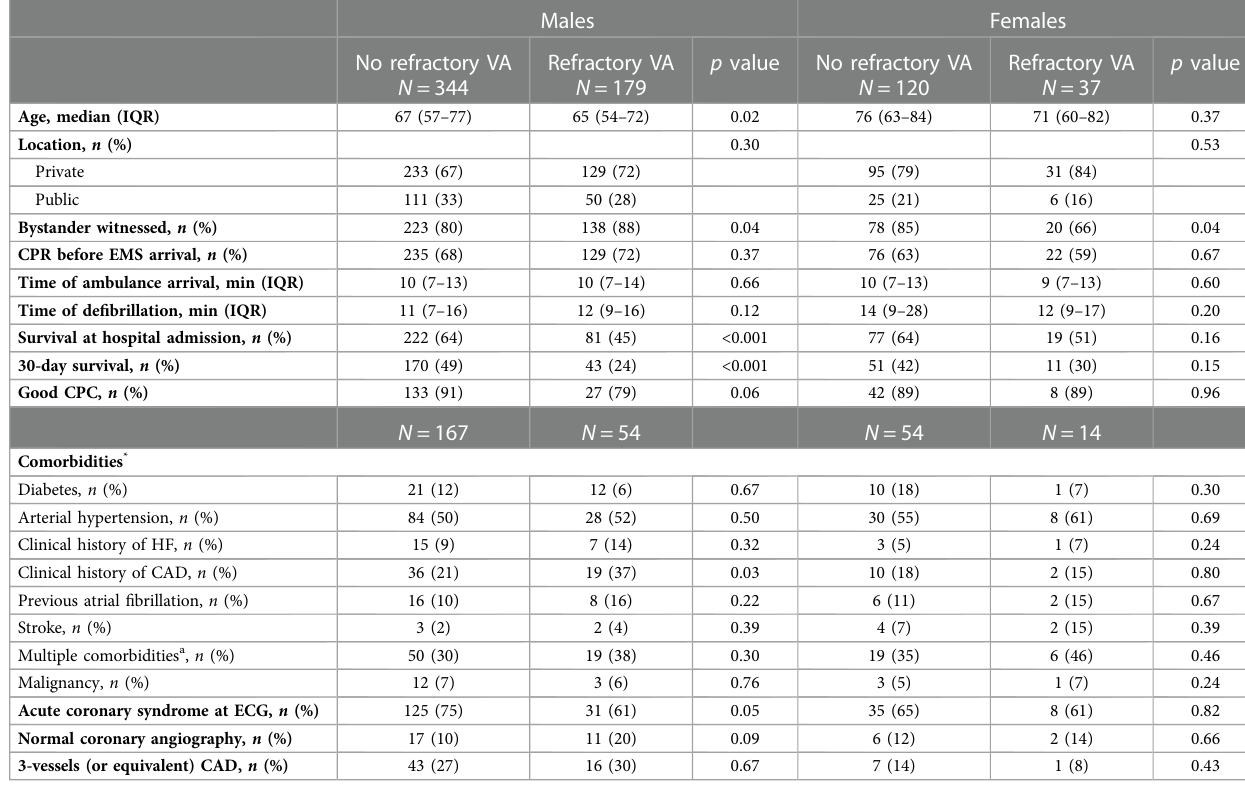
TABLE 4 Cardiovascular pro fi le, comorbidities and OHCA presentation according to